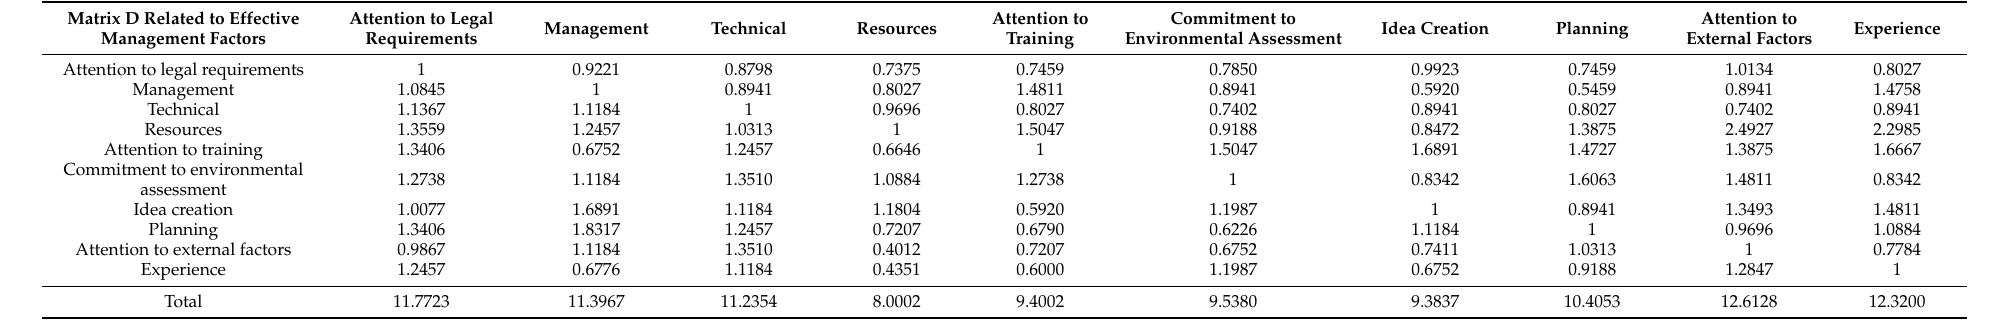
Table 2. Pairwise comparison matrix related to effective management factors and indicators in the improvement and renovation of old tissues of the city.